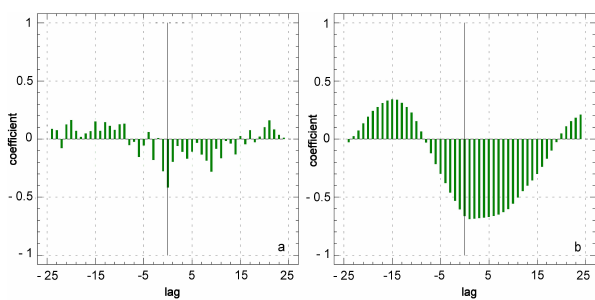
Fig. 5. Cross-correlation analysis between the long-term compo- nents of the winter NAOI and the MAEPI carried out on (a) the original time series data and (b) the 11-yr moving